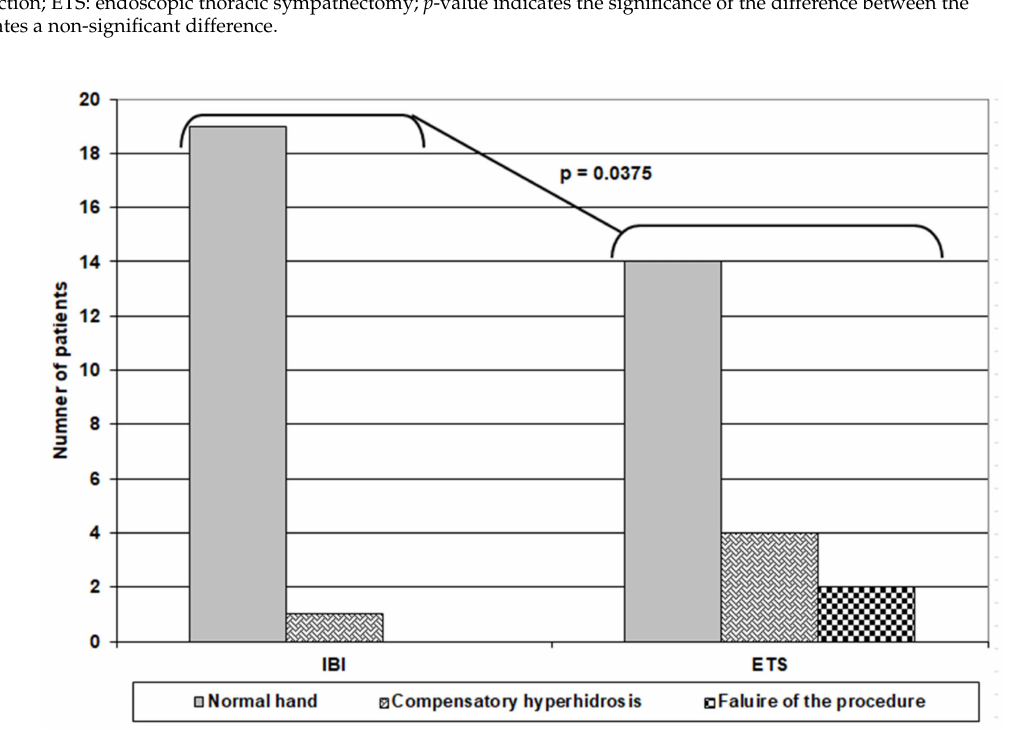
Figure 3. Outcome of patients of both groups at the end of 12-week follow